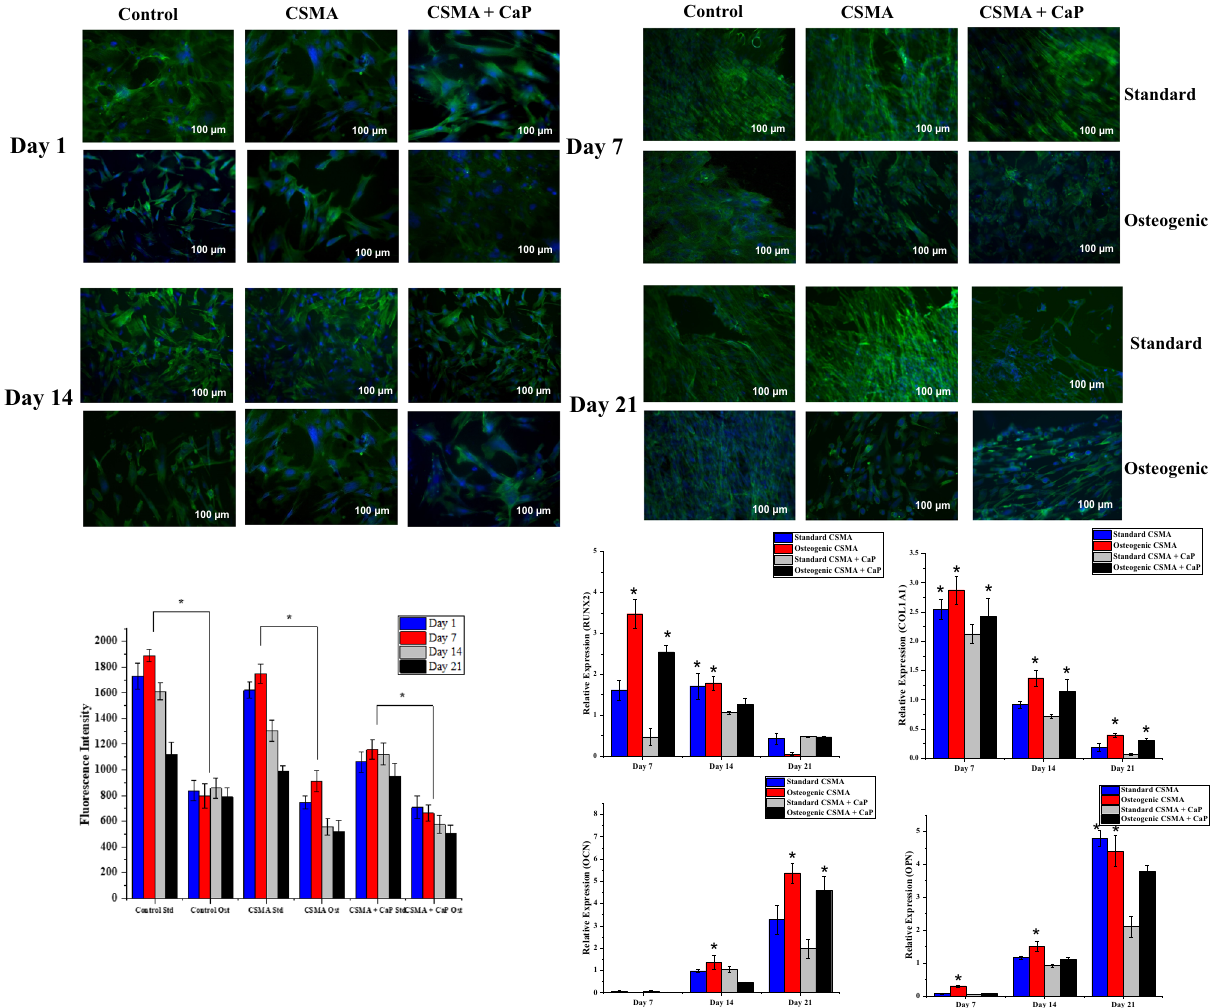
Figure 8. Phalloidin and DAPI staining represent the morphological changes of ADSCs on a coverslip control, CSMA and CSMA + CaP in osteogenic and standard growth conditions over 21 days of culture. The round like morphology at day 14 in the osteogenic sample reveals a sign of osteogenic differentiation, whereas an elongated morphology is observed in the standard condition. The metabolic activity of the cells was evaluated via Alamar blue assay where viability and proliferation of the cells show the highest level of activity at day 1 post culture with a significant difference between the standard and osteogenic media. Finally, osteogenic differentiation markers exhibit upregulation of RUNX2 and COL1A1at day 7, 14 and expression of OCN and OPN at day 21; all formulations show a higher level of relative expression in the presence of osteogenic media. The highest statistically significant values at each time point are presented with an asterisk on top in this